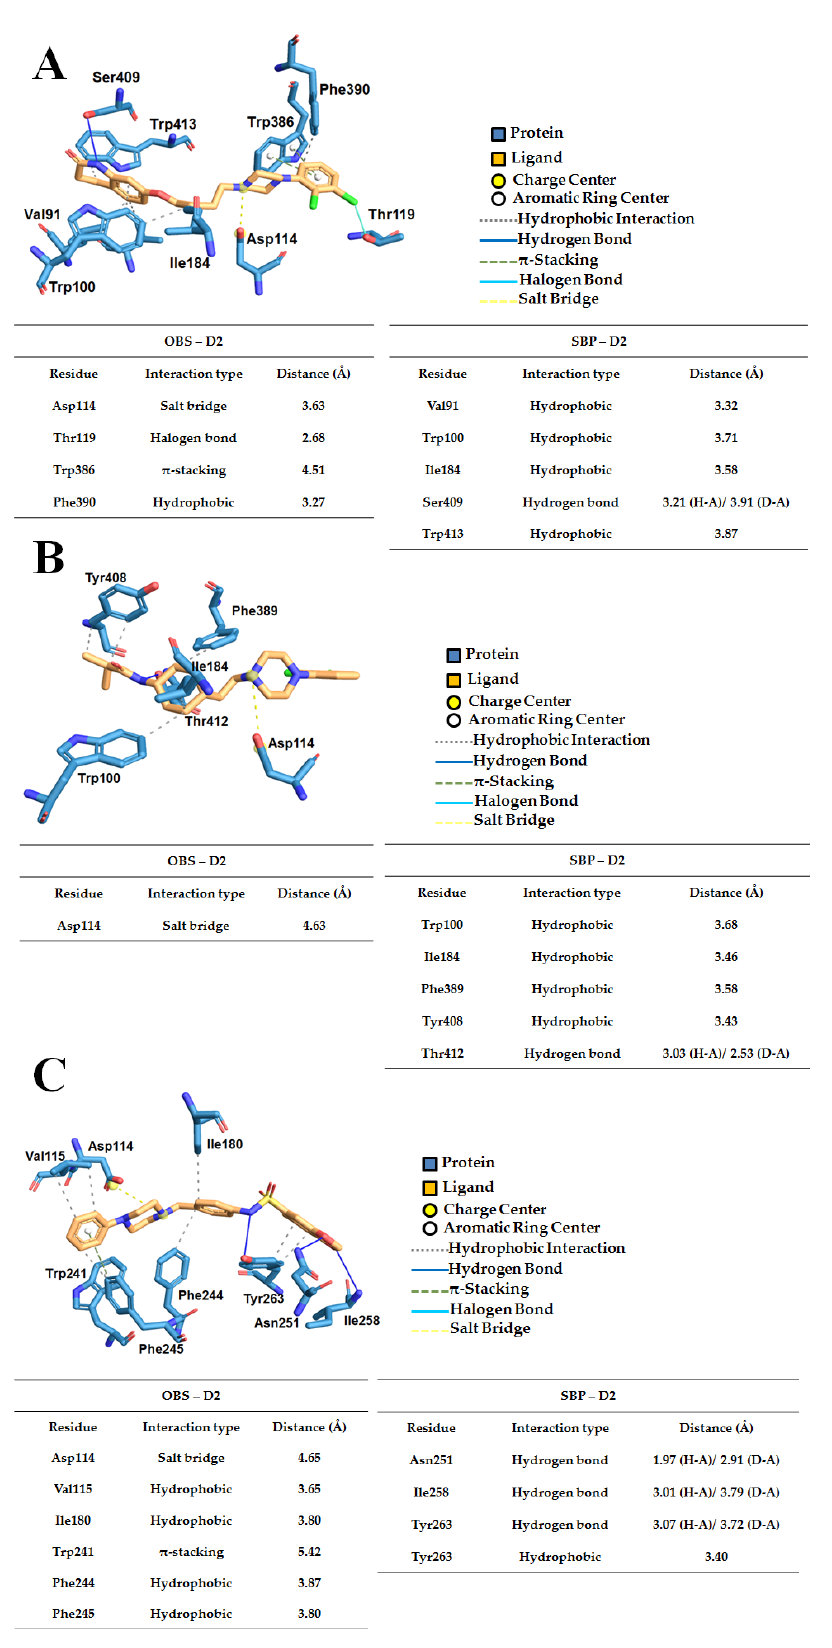
Figure 5. PLIP analysis for the prototype compounds aripiprazole ( A ) and cariprazine ( B ), and for 5a ( C ), at D2 receptors.